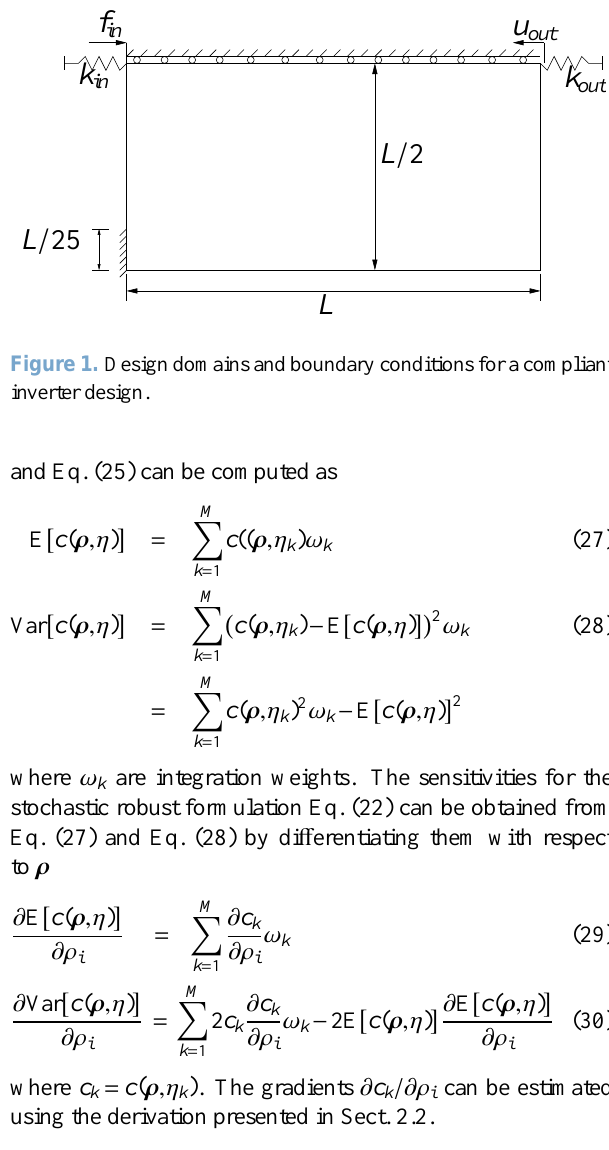
Figure 2. Boundary conditions for filtering. The bold lines corre- spond to Dirichlet BC ˜ ρ = 1 . 0, the dotted lines correspond to Neu- mann BC ∂ ˜ ρ/∂ n = 0, and the dashed lines correspond to Dirichlet BC ˜ ρ = 0 . 0. The length of the bold lines around the two springs is L / 50.